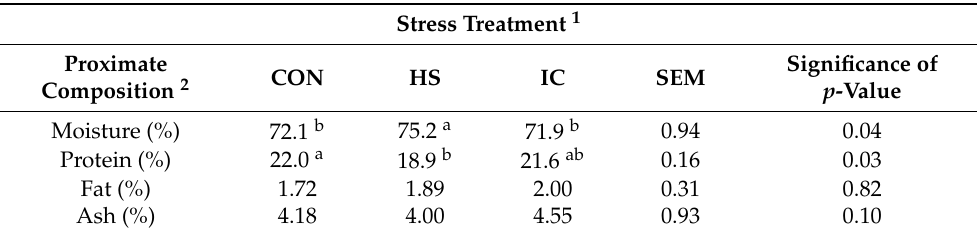
Table 7. Proximate composition of turkey meat subjected to environmental stress 1 week prior to